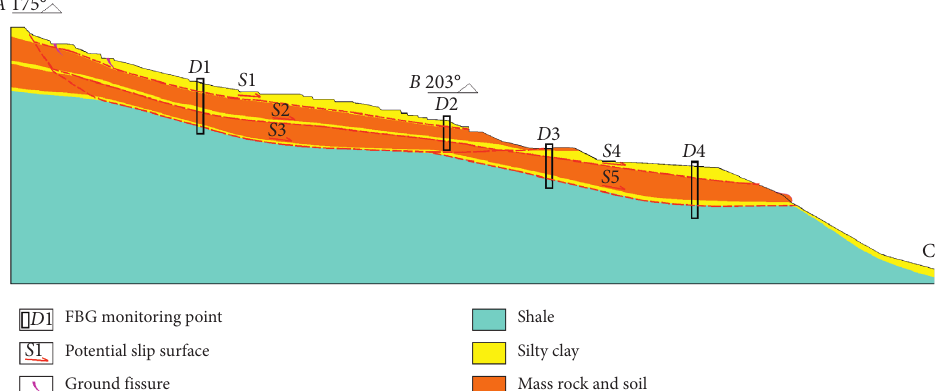
Figure 6: Cross-section of the monitoring of internal deformation for the Toudu landslide.